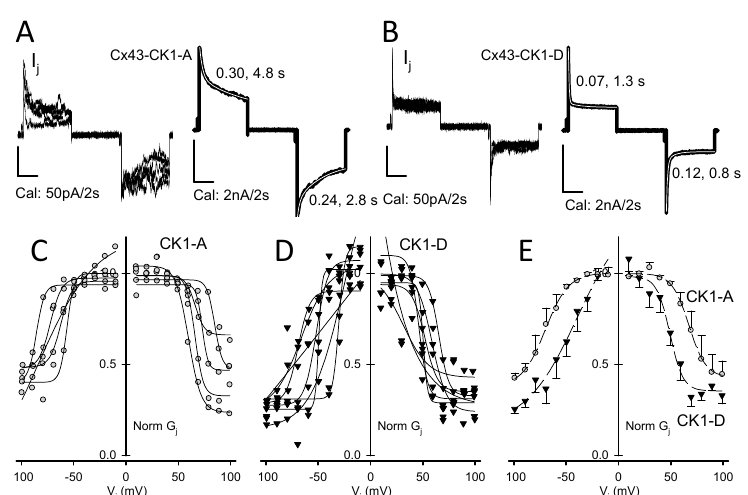
Figure 1. Cx43-CK1-D displays stronger V j -sensitivity than Cx43-CK1-A. ( A ) Five individual I j responses to V j = ±80 mV pulses (left) and sum (right) of 38 similar traces from Cx43-CK1-A cell pairs; ( B ) Five individual I j responses to V j = ±80 mV pulses (left) and sum (right) of 30 similar traces from Cx43-CK1-D cell pairs. For ( A , B ), tau values of I j inactivation (2nd order exponential decays) are shown and the fits (white) displayed over the corresponding sum traces; ( C ) V j -dependence of G j from individual experiments in Cx43-CK1-A ( g j = 2.8 ± 1.0; n = 5) cell pairs; ( D ) V j -dependence of G j from individual experiments in Cx43-CK1-D ( g j = 1.7 ± 1.1; n = 7) cell pairs. For ( C , D ), g j from each experiment was normalized as described in the Methods and the Boltzmann fits are shown in solid black lines; ( E ) Average V j -dependence for CK1-A (gray circles) and CK1-D (black triangles) and their corresponding Boltzmann fits (dashed lines). Fast inactivation and V 0 values were different between Cx43-CK1-D and Cx43-CK1-A. For fitting parameters, see Tables 1, S1 and S2.